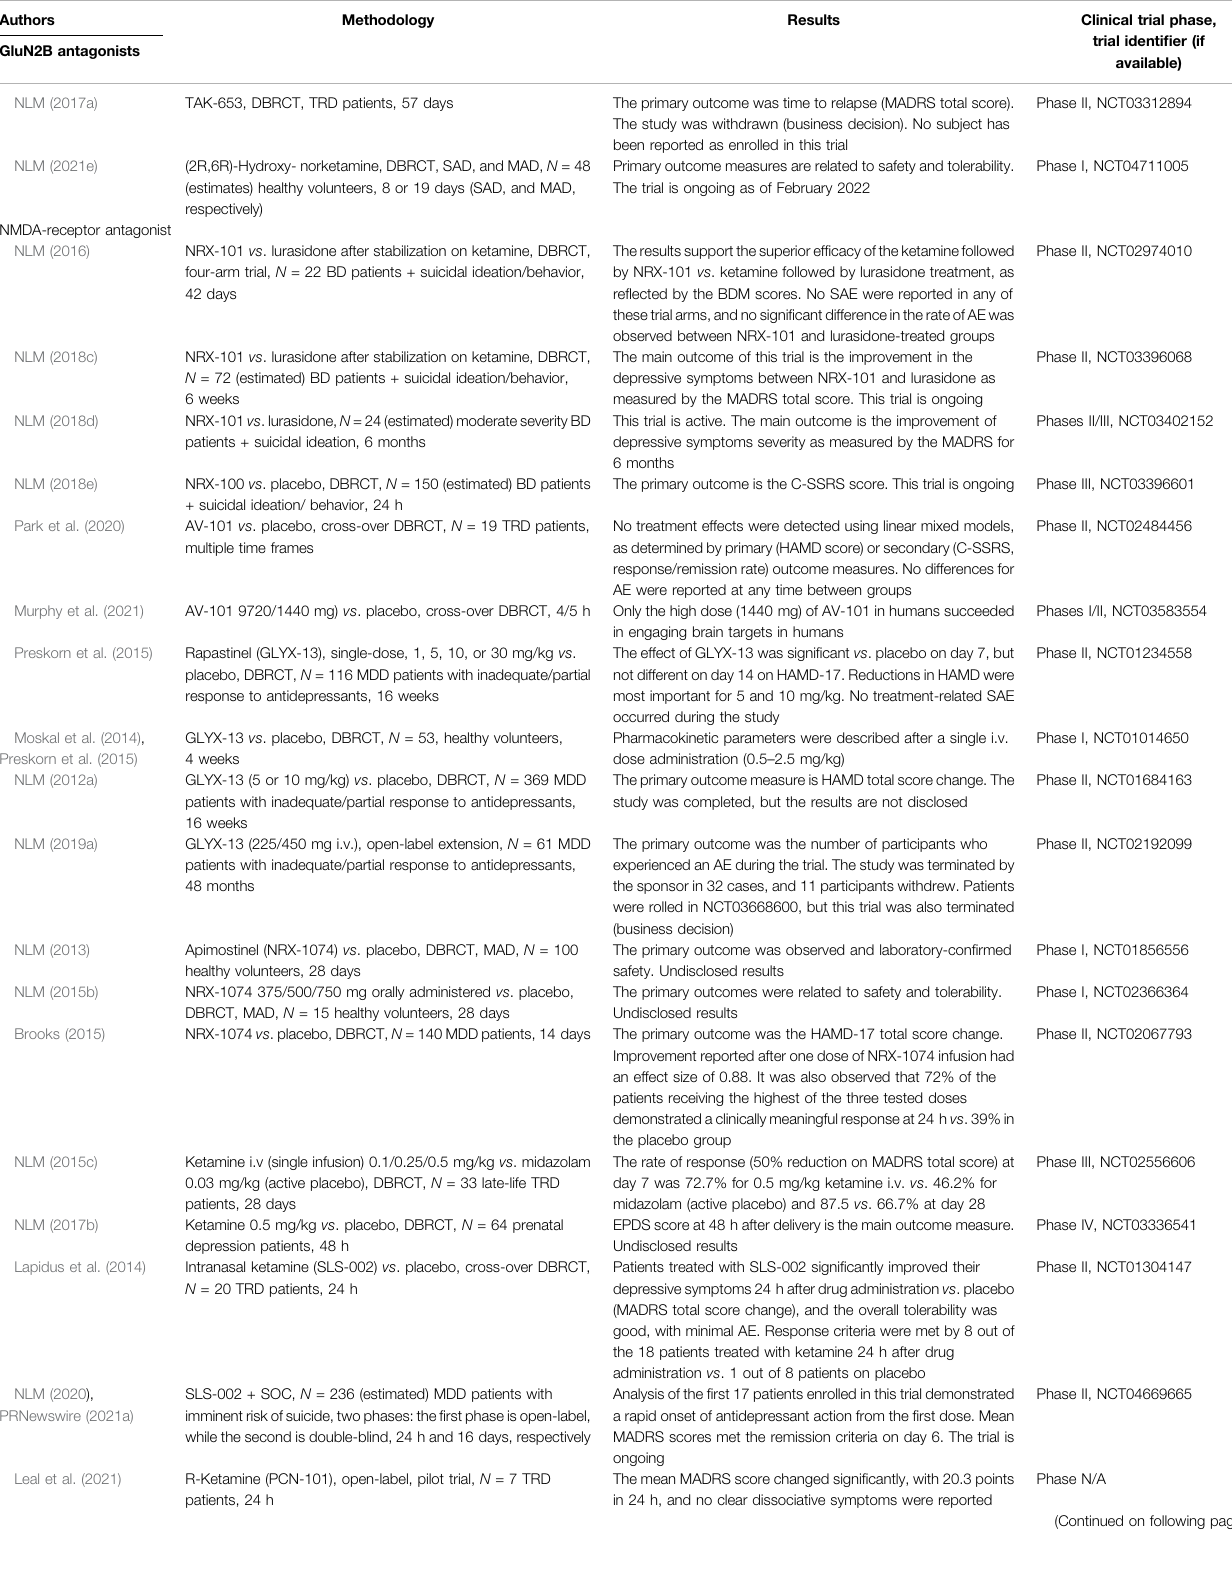
TABLE 1 | ( Continued ) Glutamatergic agents with antidepressant properties in the